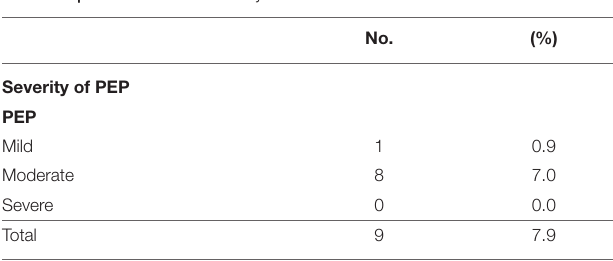
TABLE 3 | Prevalence and severity of PEP.